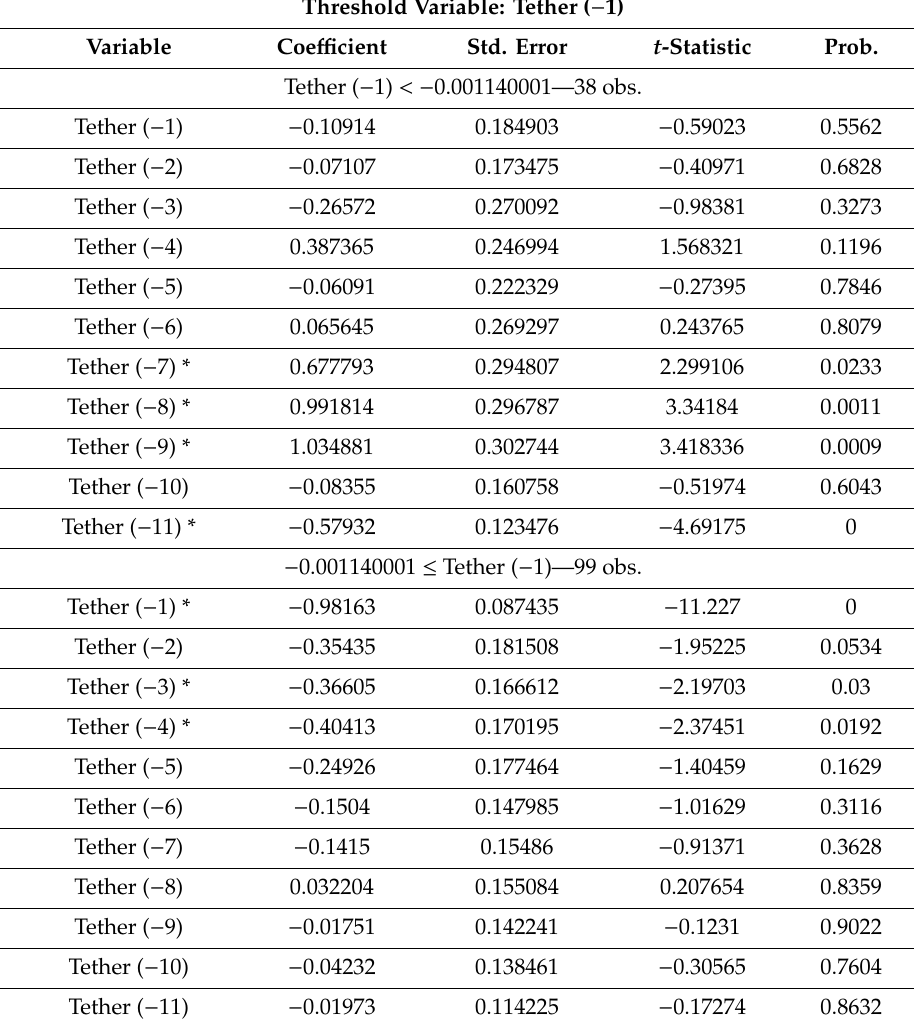
Table 4. Threshold autoregression (TAR) model